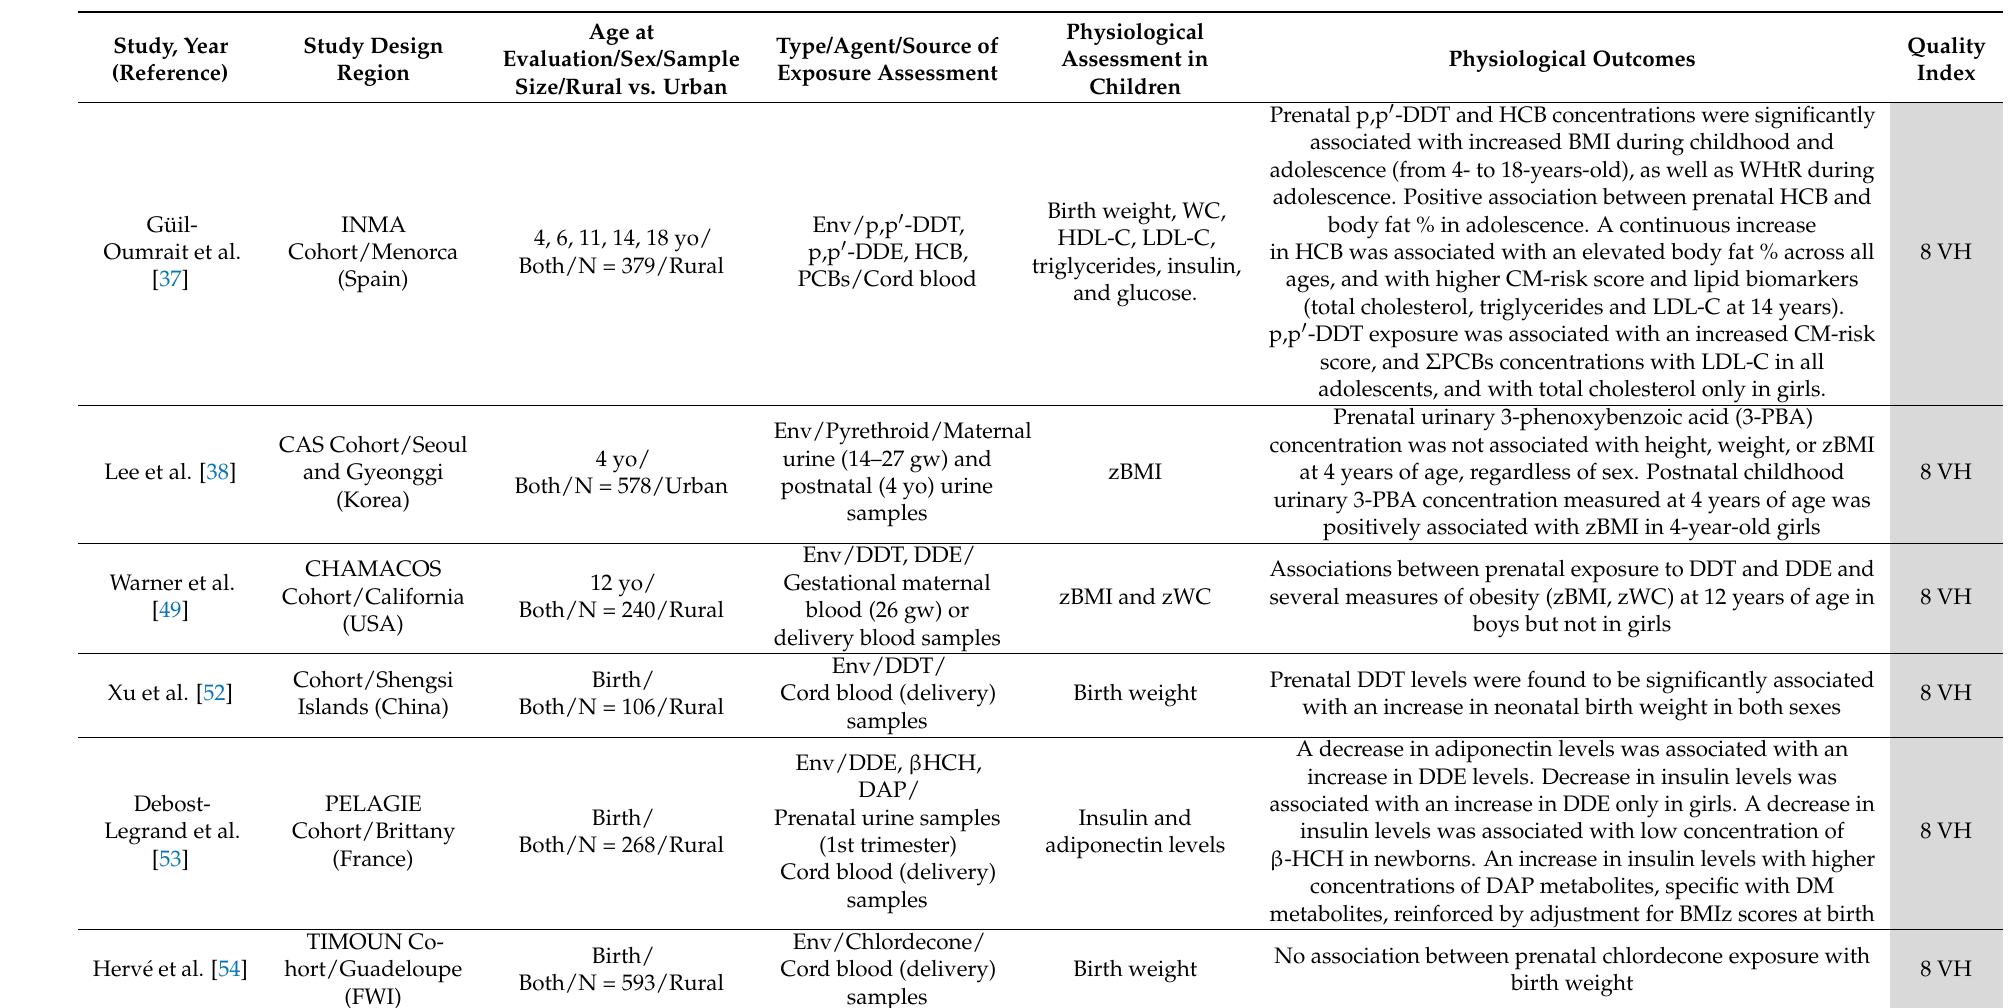
Table 1. Effects of pesticide exposure on risk of obesity in clinical